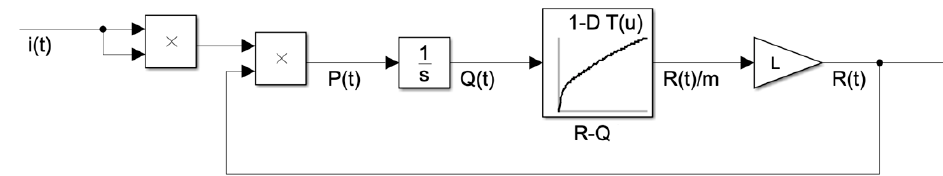
Figure 2. Block diagram of RQ Model.